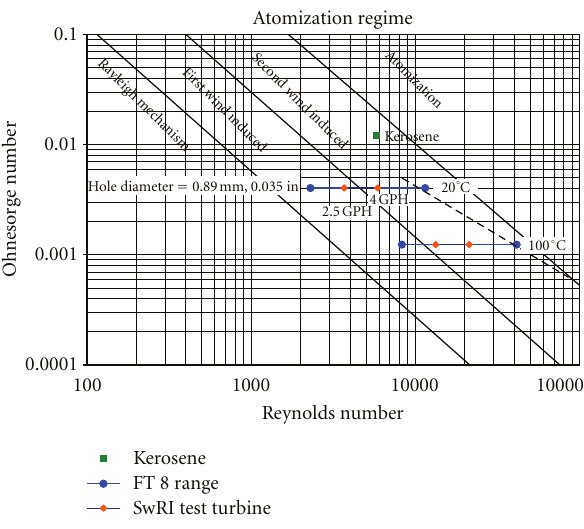
Figure 4: Atomization regime